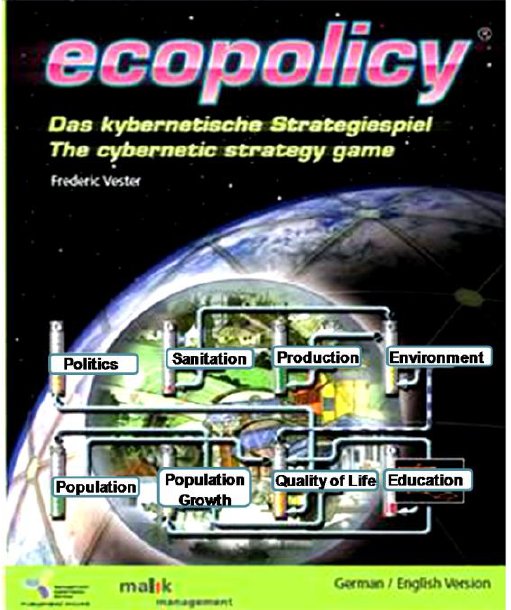
Figure 2. Ecopolicy cybernetic strategy game